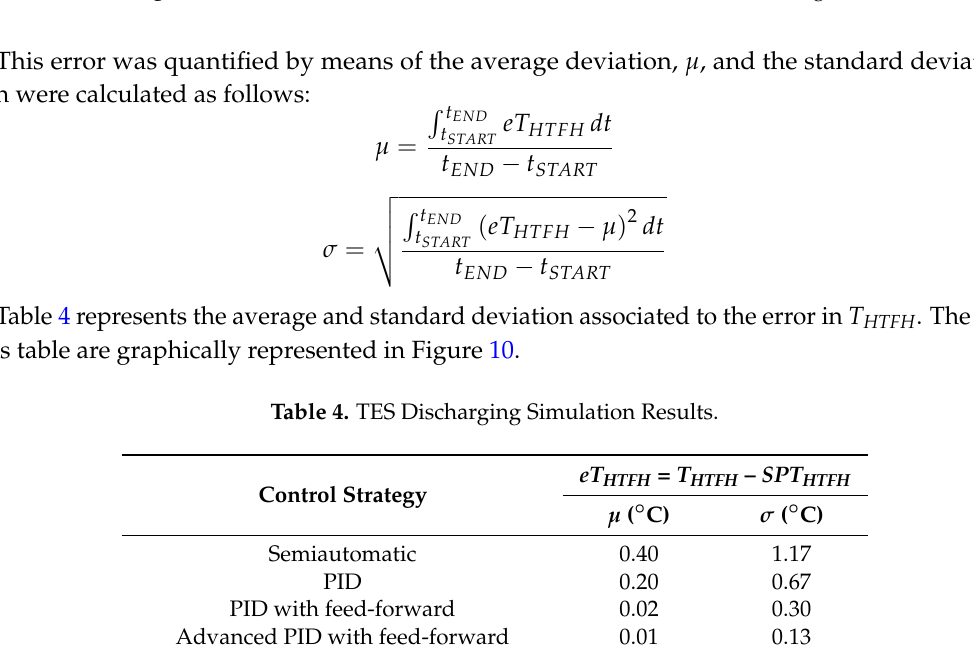
Figure 10. Graphic representation of the simulation results.